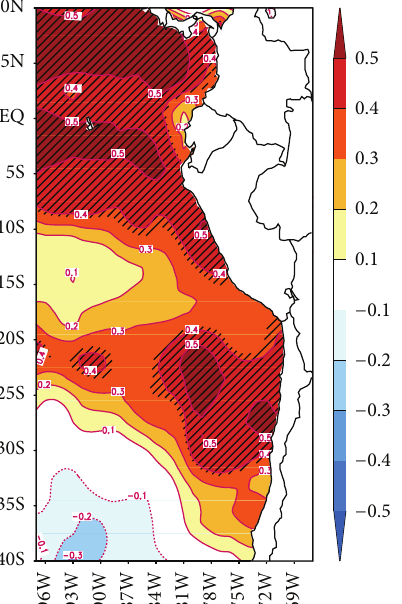
Figure 8: JJA correlation of EIS index with NOAA OI SST shaded and contoured (data from 1982–2009). Hatched areas are significant at 90% for a 2-tailed test.